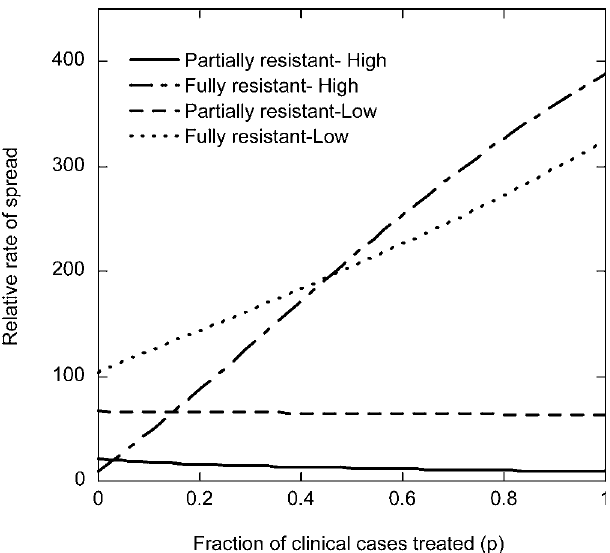
Figure 5. Effect of IPT Treatments with Drugs with Different Half-Lives (CPG-DDS or SP) on the Percent Increase of R1 Relative to RS in a Low- Transmission Setting Drugs with shorter half-lives (i.e., CPG-DDS) reduce the window of selective advantage of more resistant parasites. DOI: